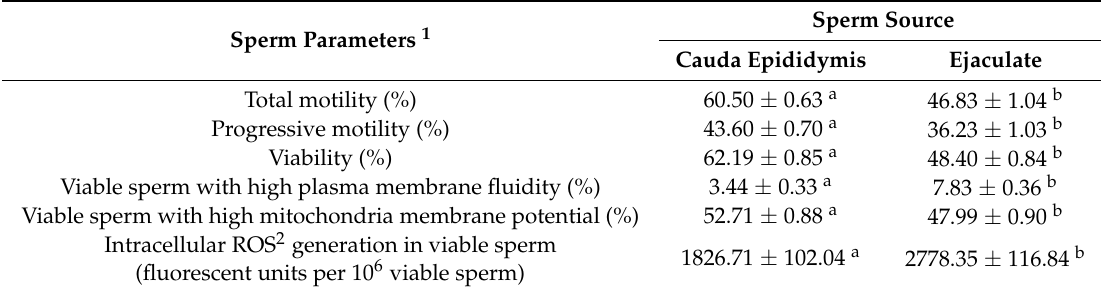
Table 1. Post-thawing parameters (mean ± SEM) of mature pig spermatozoa collected from the cauda epididymis and ejaculates of 10